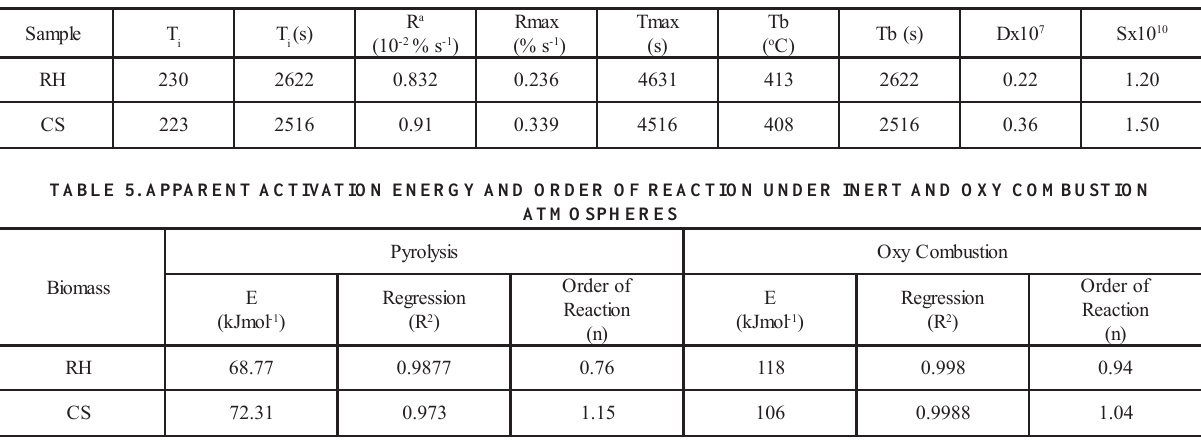
TABLE 4. COMBUSTION CHARACTERISTICS OF SAMPLES UNDER OXIDATIVE ENVIRONMENT